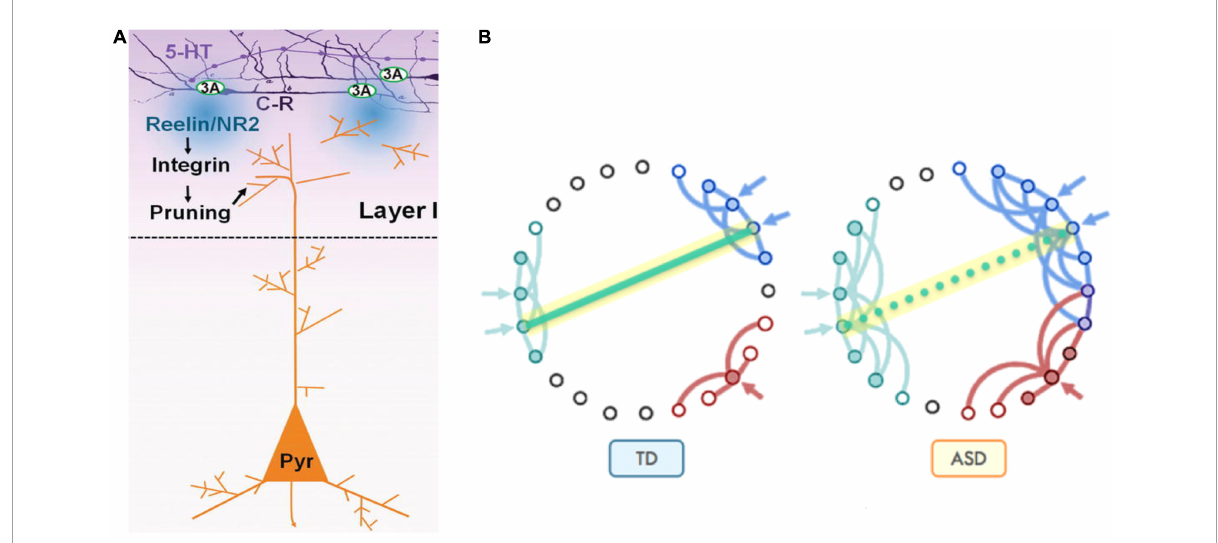
FIGURE11 (A) Synaptic pruning in brain development serves to refine communication between functional areas by improving the signal-to-noise ratio. At early postnatal stage, Cajal-Retzius cells (C-R) that express 5-HT3A, respond to 5-HT by releasing reelin which, through the activation of the integrin signaling pathway, induces pruning of apical dendrites of pyramidal neurons (Pyr). (B) Pruning reduces unnecessary cross-talk with neighboring nodes (blue and red in typical development, Panel TD). However, in the presence of too many overlapping connections, distinct signals from neighboring communities may compete and interfere with each other, effectively creating noise and "confusion" within the network (blue and red in autism spectrum disorder, Panel ASD), while negatively affecting the development of long-distance connectivity, such as those between fronto-parietal regions for higher-order executive functions [adapted from Belmonte et al. (2004), Just et al. (2012), and Vitalis and Verney (2017)], obtained by Elsevier (No. 5410821023270) under a creative commons license